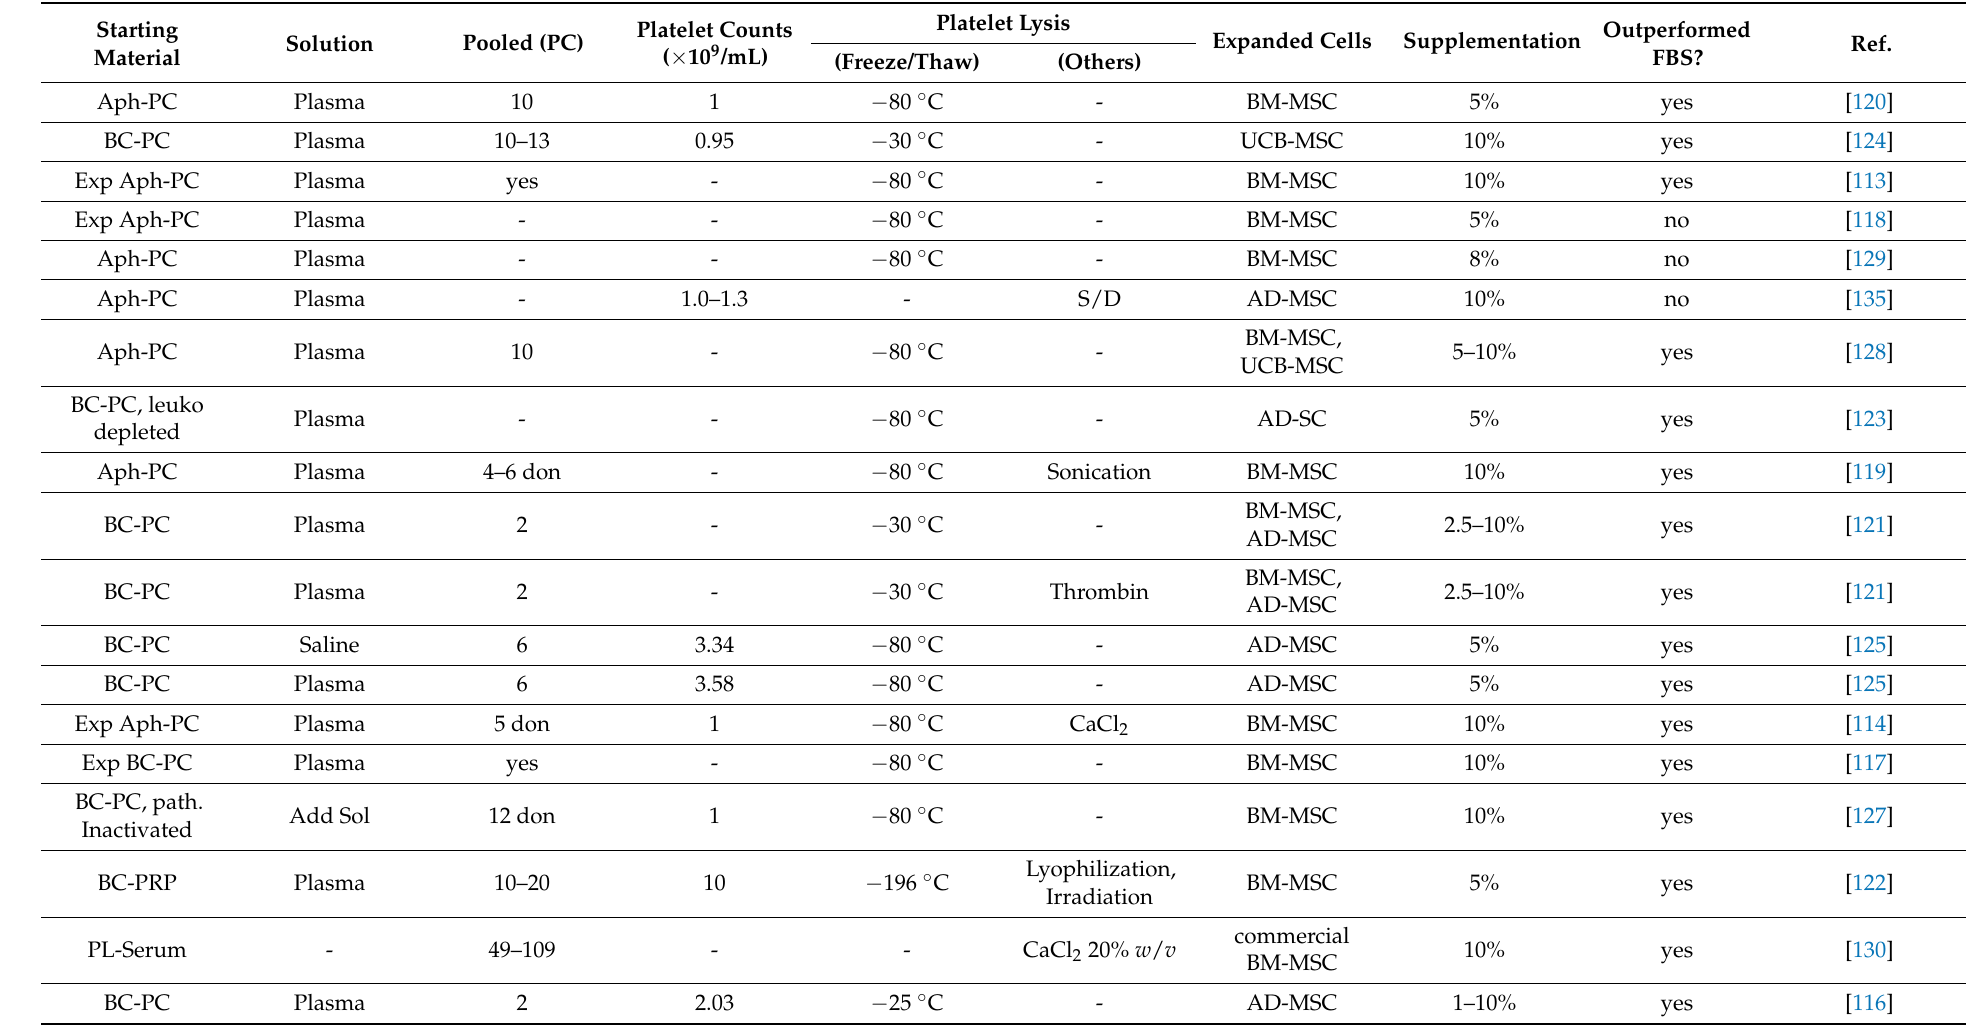
Table 2. Human platelet lysate (hPL) as alternative to bovine serum; selected studies from 2005 to 2020 including commercially available products. Information is provided on starting material, preparation technique and culture